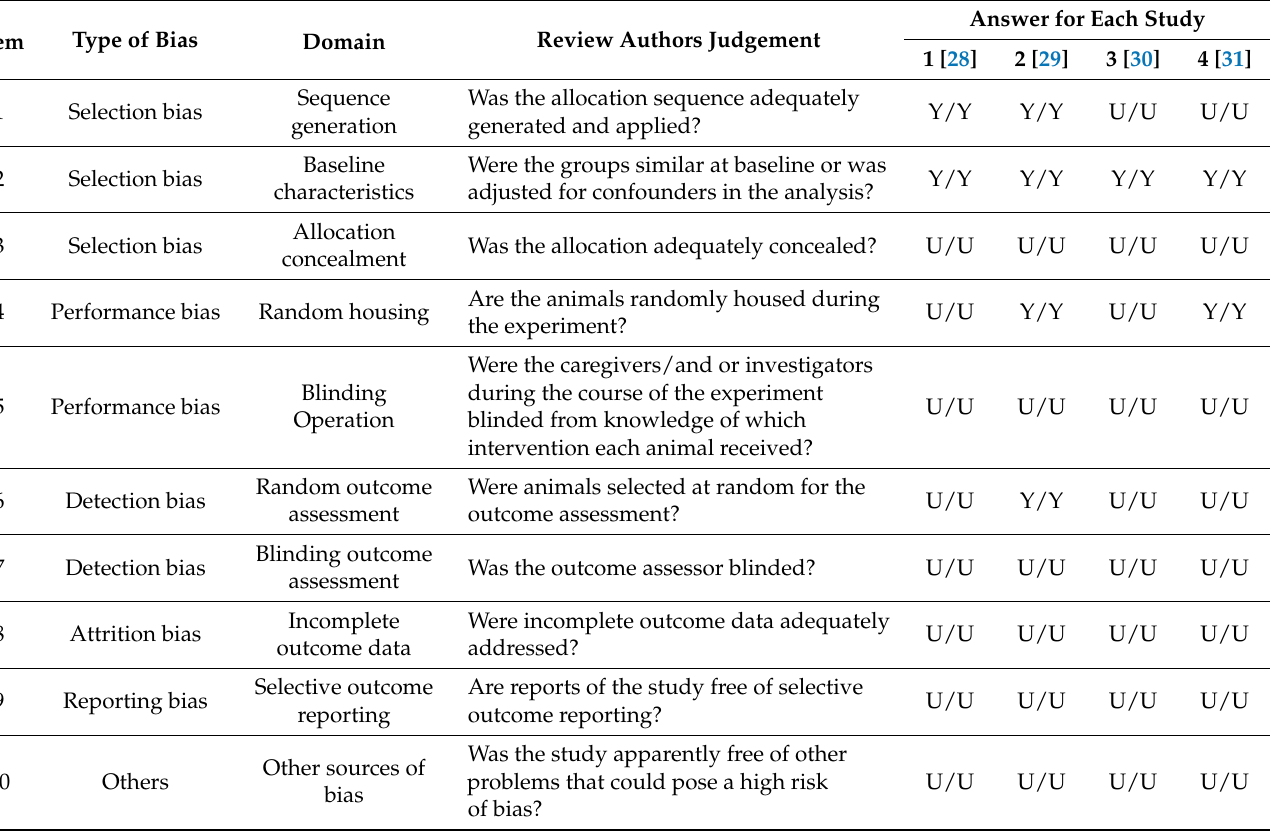
Table 1. SYRCLE’s Risk of Bias Tool [27].